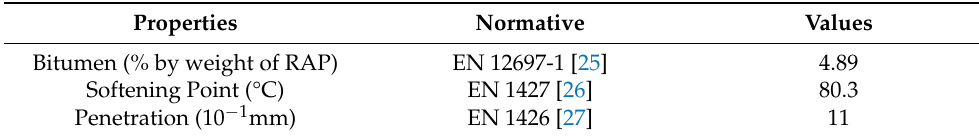
Table 2. Properties of the recovery